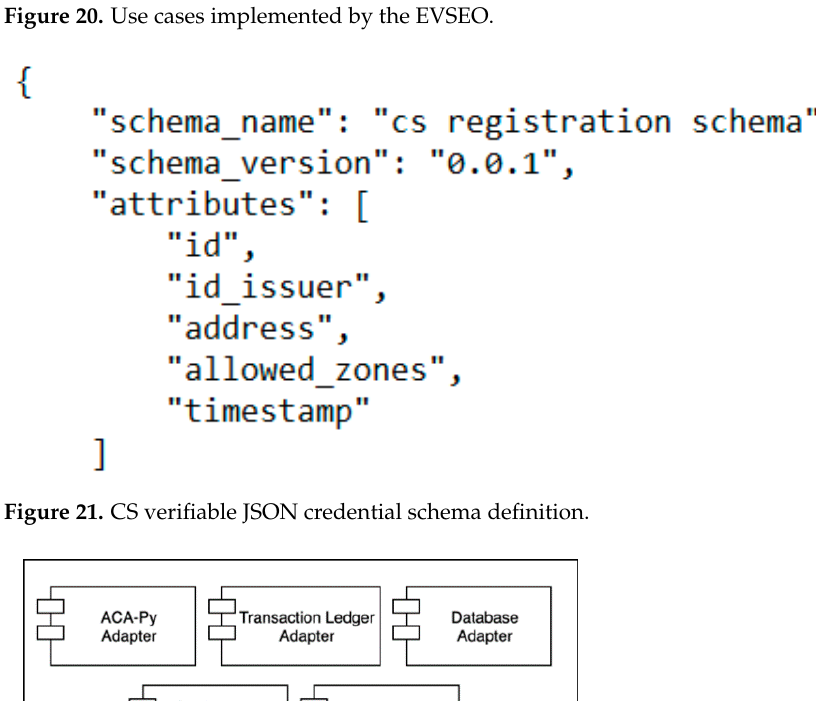
Figure 21. CS verifiable JSON credential schema definition.